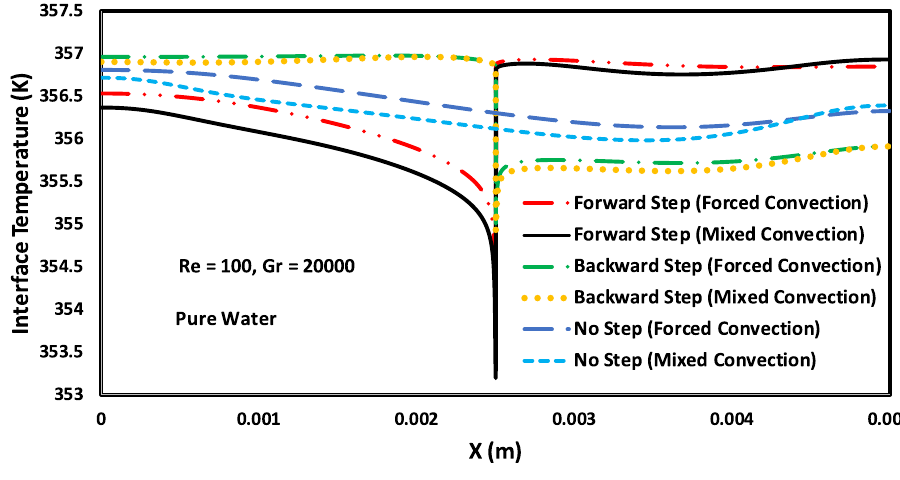
Fig. 6 Temperature distribu- tion along the solid–fluid interface of the lid-driven cavity in the case of pure water at Re = 100 and Gr = 20,000 in all three geometrical configu- rations for forced and mixed